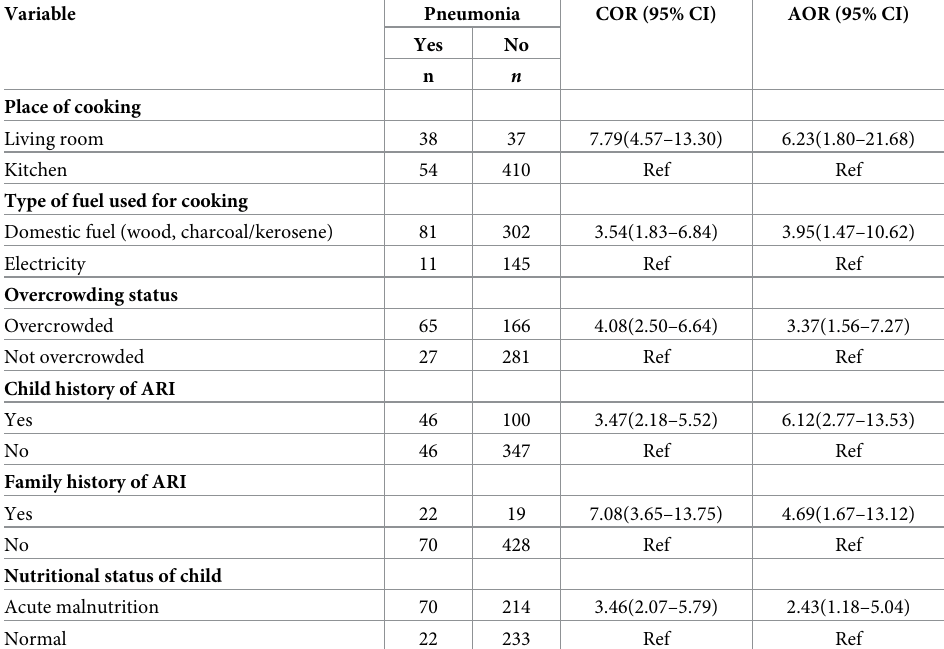
Table 5. Factors significantly associated with pneumonia among children under five from multivariable logistic regression analysis in peri-urban areas of Dessie City, north-eastern Ethiopia, January—March